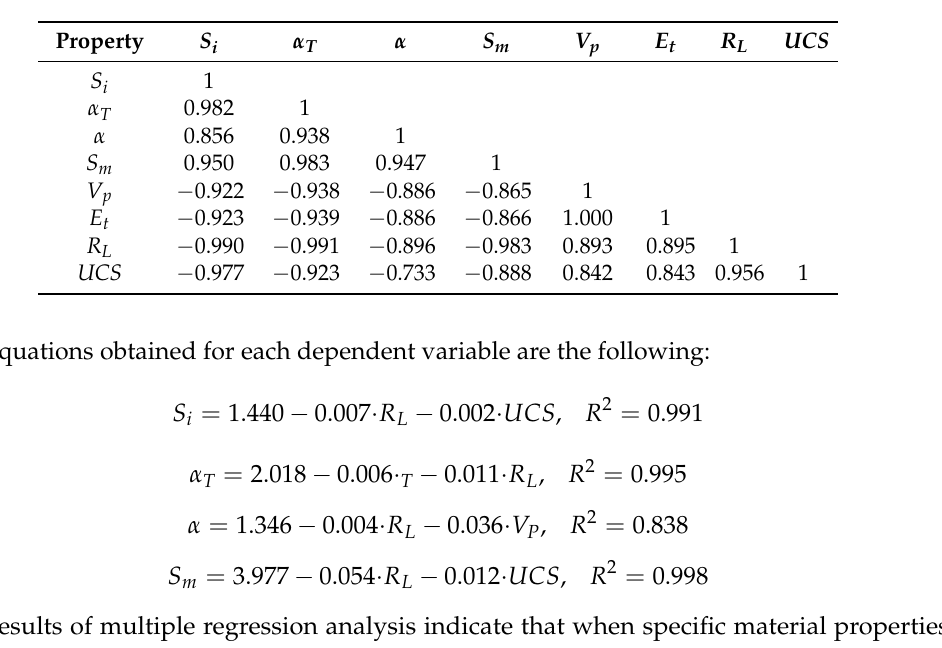
Table 6. Correlation matrix for study